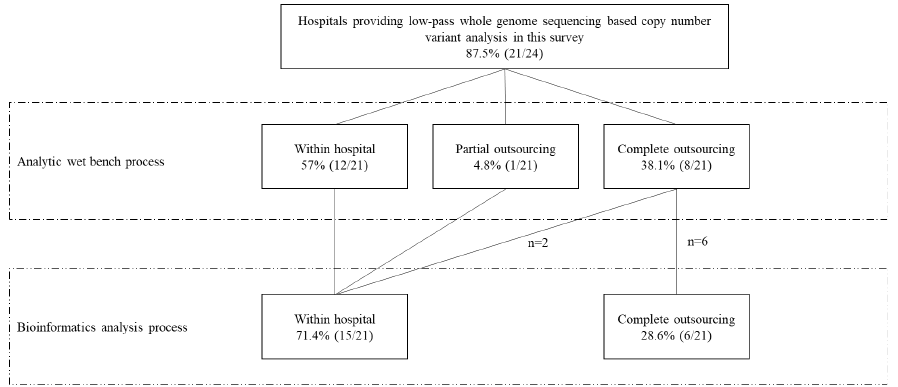
Figure 2. Capacity of conducting low-pass whole-genome sequencing-based copy number variant analysis within hospitals among 21 Chinese tertiary hospitals in this survey.